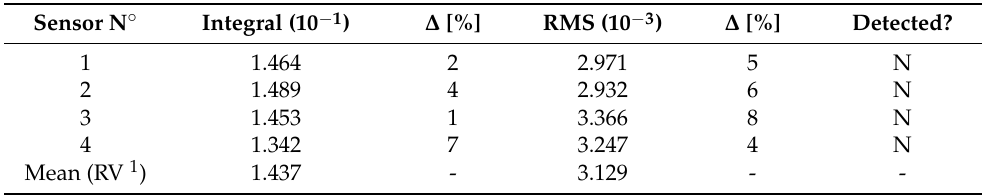
Table 12. Integral and RMS of frequency spectrum, solid slab.